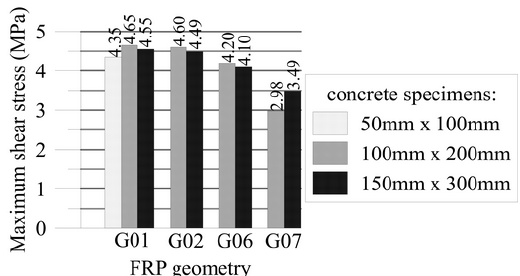
Figure 12. Comparison of the maximum shear stress in the debonding failure in experiments with different specimen